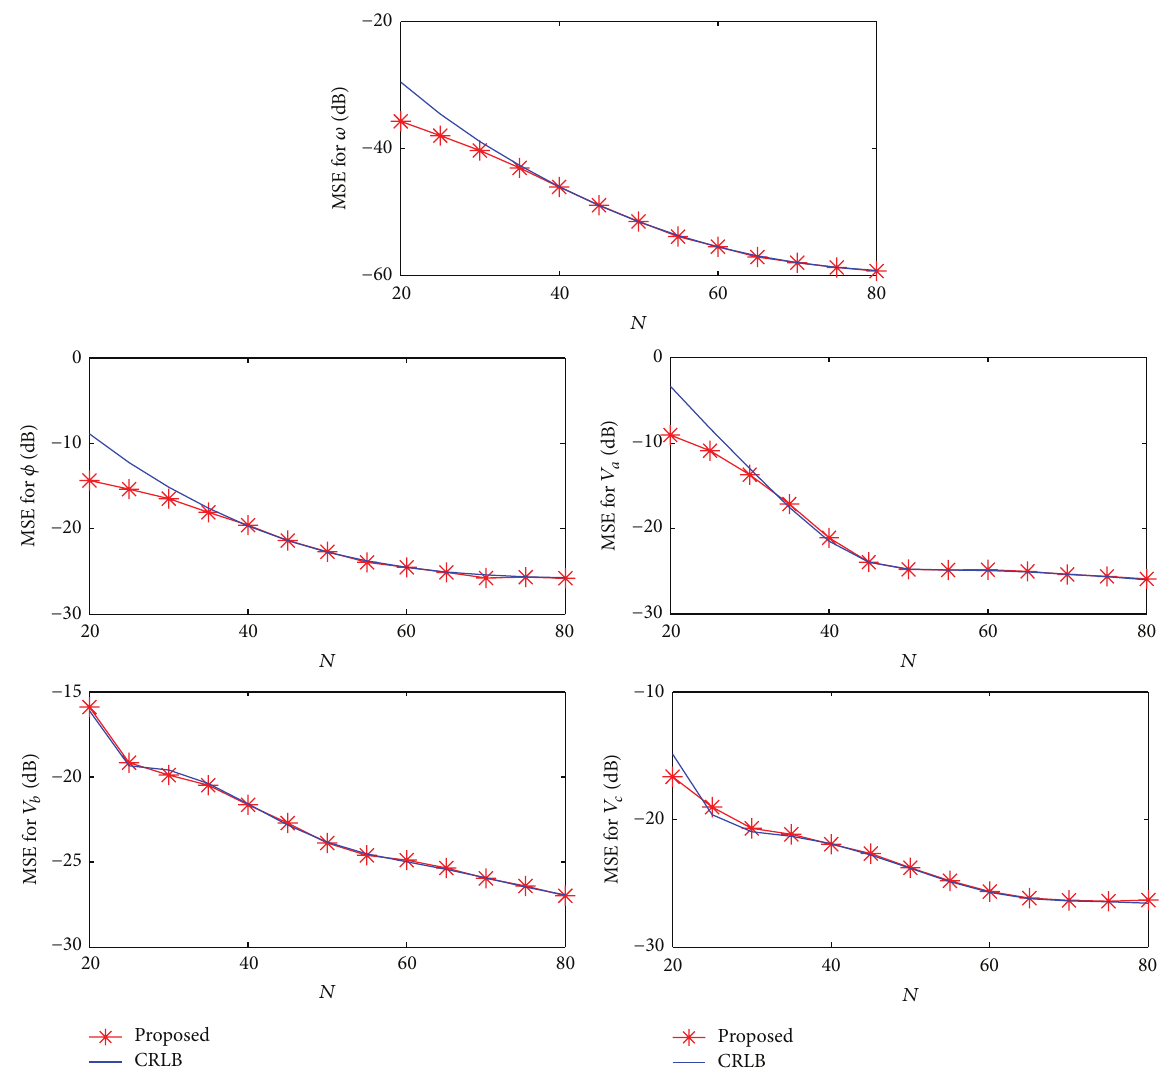
Figure 2: Mean square errors versus 𝑁